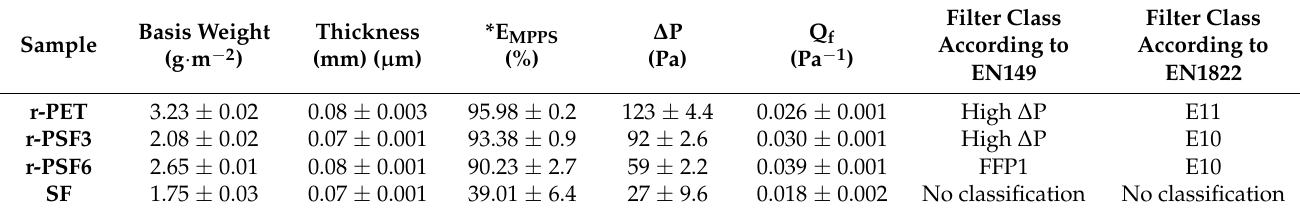
Table 6. Summarized results from measurement of the filtration activity of investigated fibrous mats: SF, r-PSF3, r-PSF6, and r-PET. The basis weights of the investigated mats were between 1.75–3.23 g · m − 2 . The membranes were classified according to Standard EN 149. The values are listed in the form mean ± SD (standard deviation).